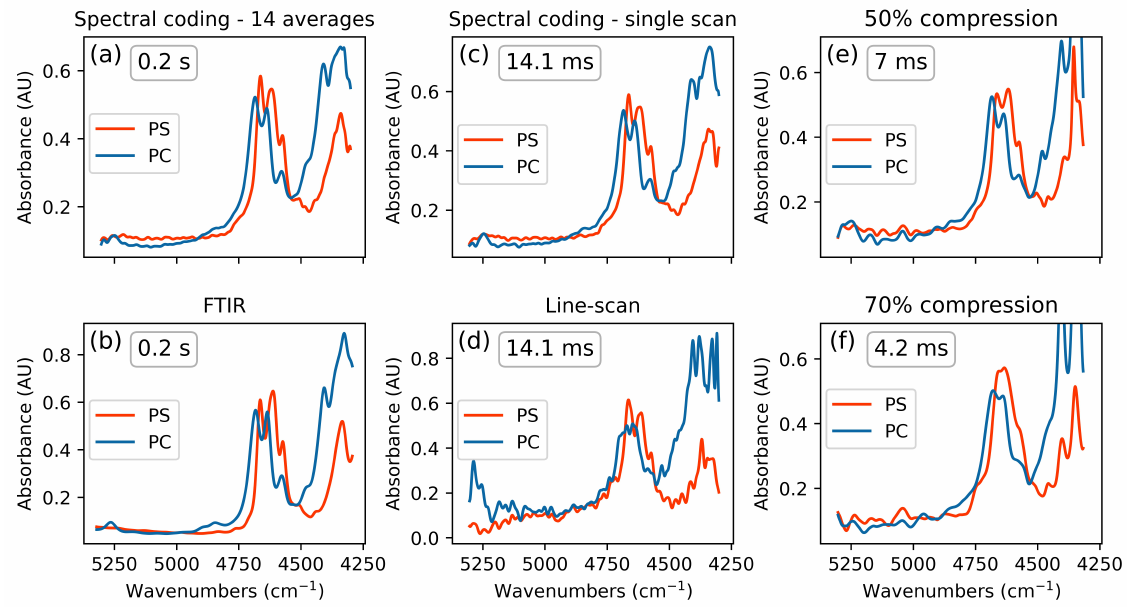
Figure 4. PC and PS absorbance spectra (AU, absorbance units) recorded with different approaches and different resulting acquisition times; ( a ) recorded with the spectral coding-based grating spectrometer; ( b ) reference absorbance spectra recorded with a standard FTIR spectrometer; ( c ) spectral coding approach with a DMD pattern switching rate of 18.2 kHz; ( d ) imitation of a conventional grating spectrometer by making line-scans of the spectra using single bar illumination masks; ( e ) compressive measurement approach with a compression of 50%, a loss in spectral resolution can be observed; ( f ) 70% compression of the measurement leads to a loss in spectral resolution but decreases the acquisition time to below 5